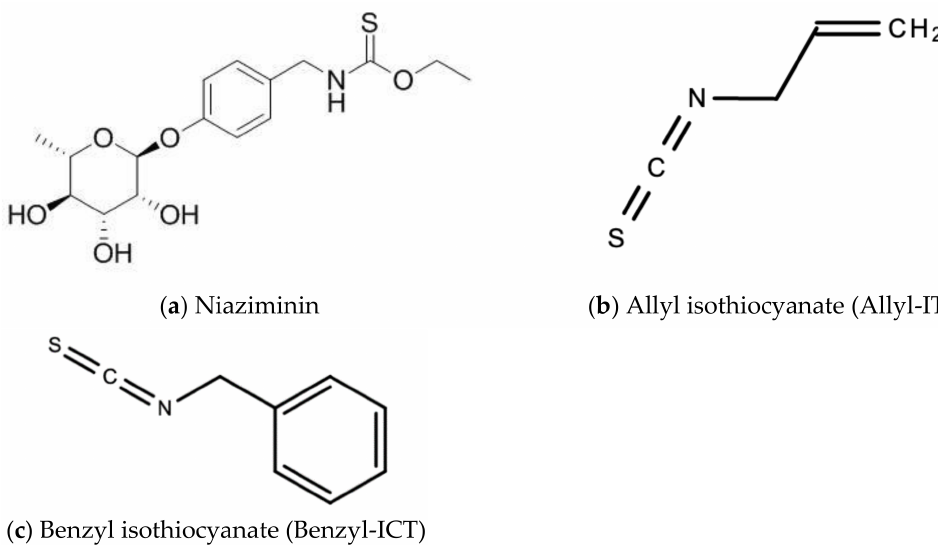
Figure 12. Chemical structures of some bioactive molecules found in Moringa oleifera Lam. In another in vitro study, the effects of an aqueous extract of M. oleifera (leaves) were able to decrease the expression of hepatitis B virus genotypes C and H in Huh7 cells